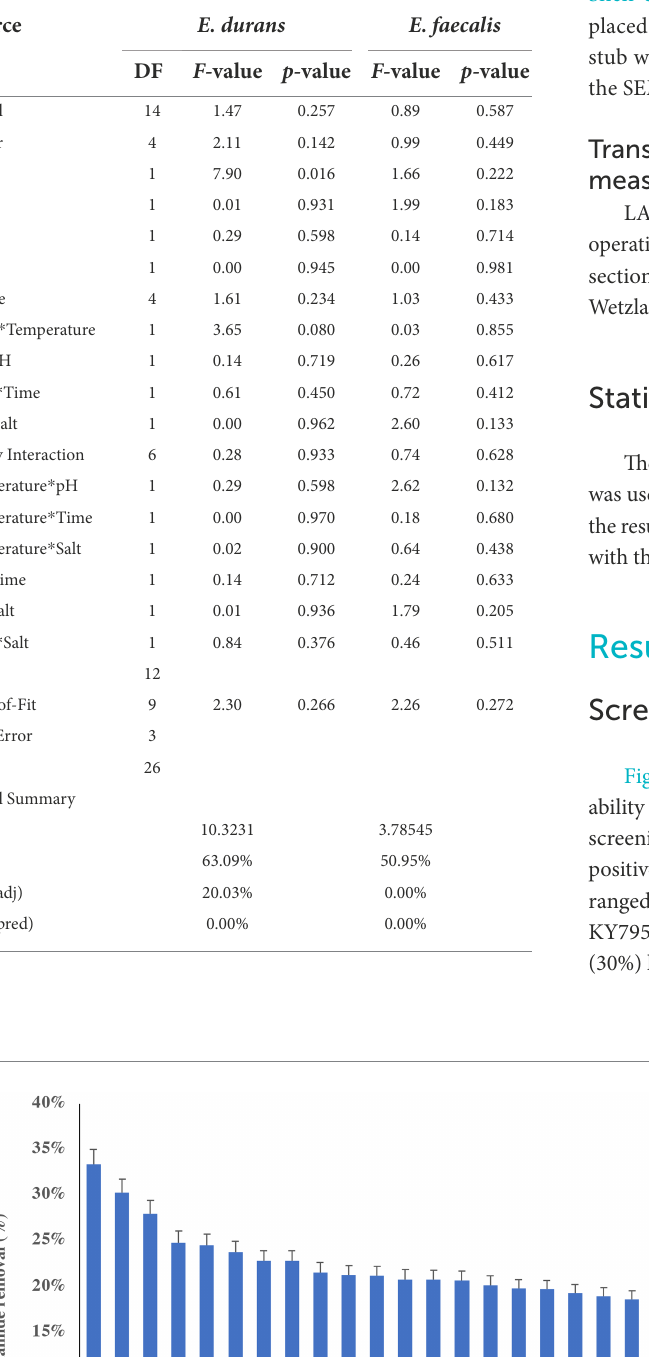
TABLE 2 Analysis of variance for E. durans and E.